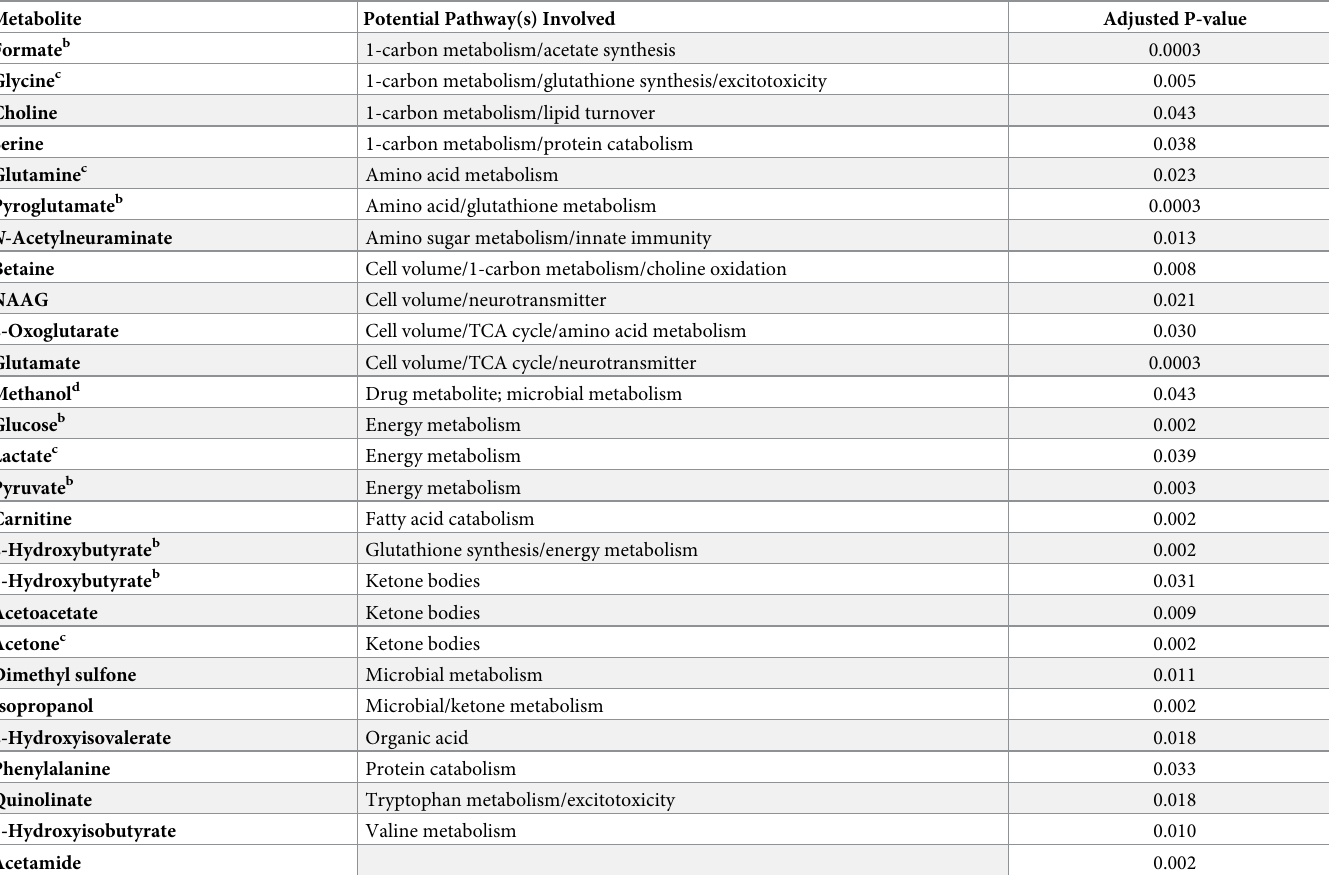
Table 3. Metabolites with differences in cerebrospinal fluid concentrations between two or more disease groups a